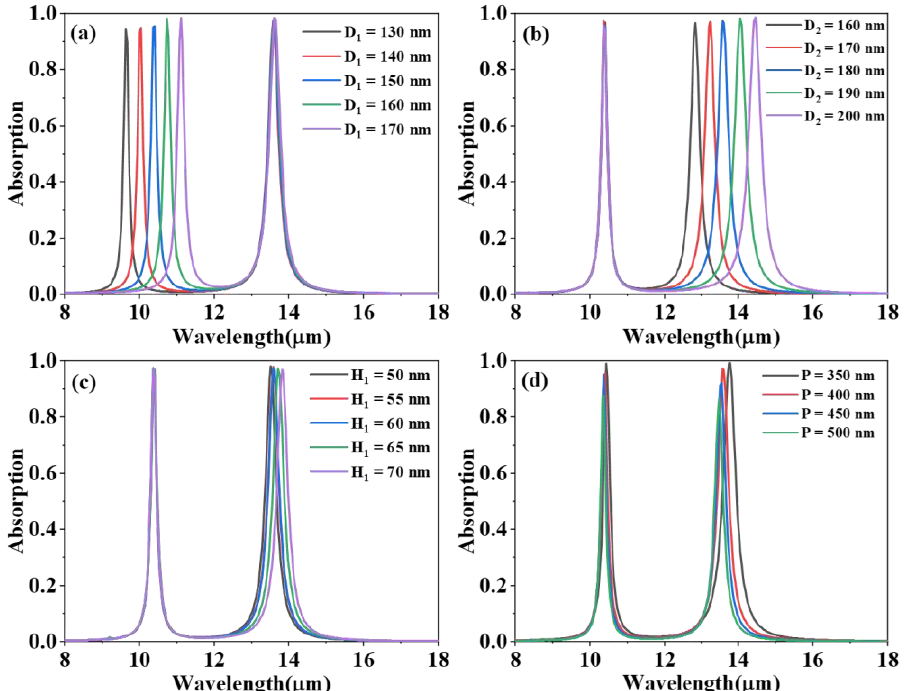
Figure 5. Absorption spectra of the proposed absorber for different ( a ) diameters D 1 of the upper graphene nanodisk, ( b ) diameters D 2 of the lower graphene nanodisk, ( c ) thickness H 1 of the upper dielectric, and ( d ) the period P of the structure.